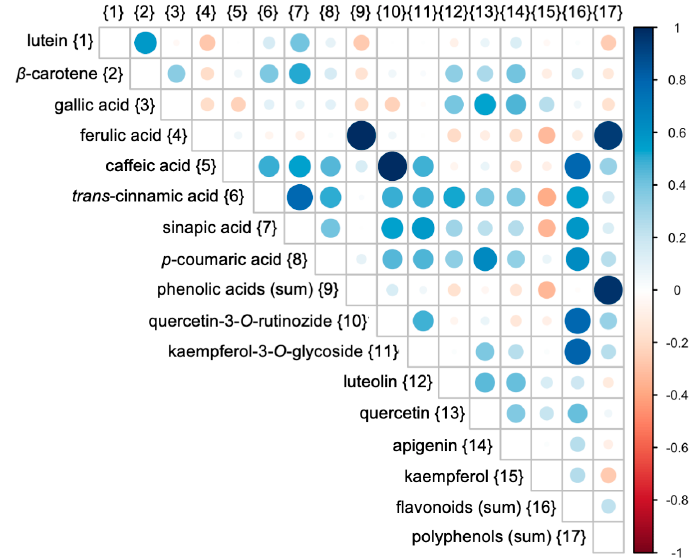
Figure 5. Pearson’s correlations between the concentrations of bioactive compounds (phenolics and carotenoids) identified in barley samples. Color (red/blue) and color intensity indicate the direction and the strength of the association, while size of the circle reflects statistical significance of the correlation ( p -value).